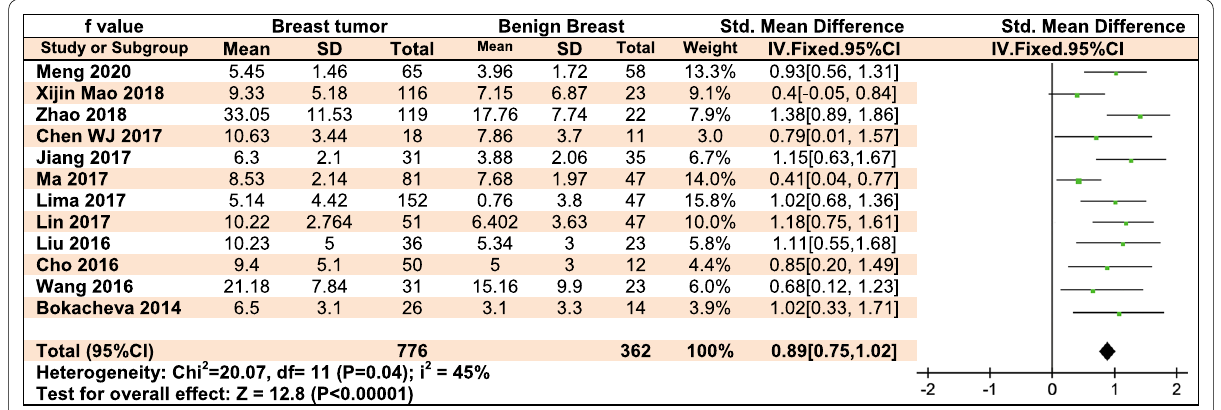
Fig. 5 The mean value of the perfusion volume fraction ( f ) distinguished among breast